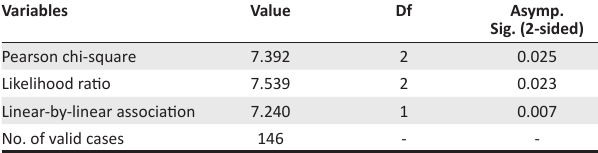
TABLE 1c: Chi-square tests: Export experience and knowledge and management of border issues. Variables